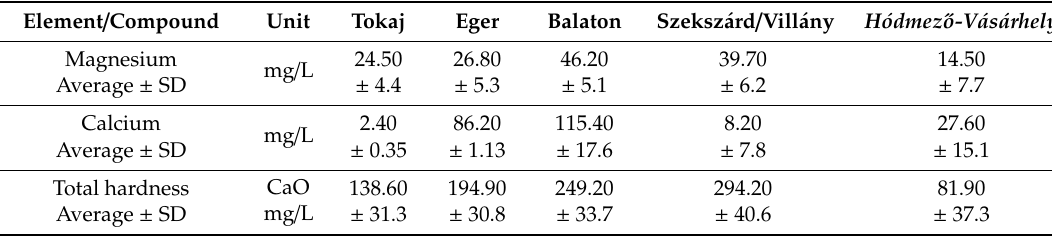
Table 2. The indicators of hardness of drinking water in the five territories.